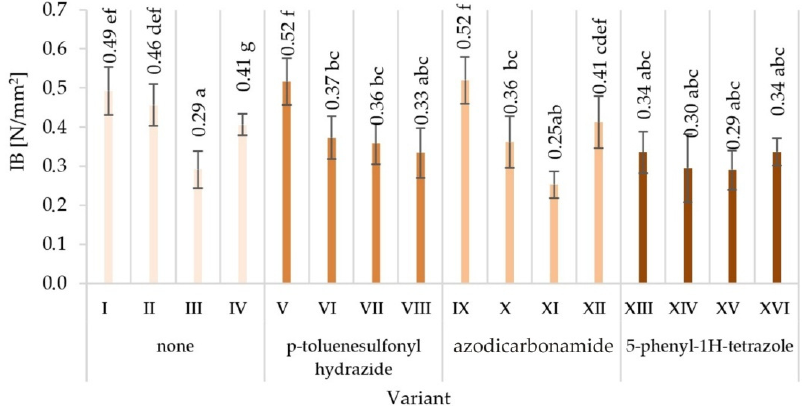
Figure 4. Modulus of elasticity (MOE) of particleboards produced (means and standard deviation, a, b, c, . . . —homogeneous groups determined by the Tukey test; different letters denote a significant difference; means followed by the same letter do not statistically differ from each other).